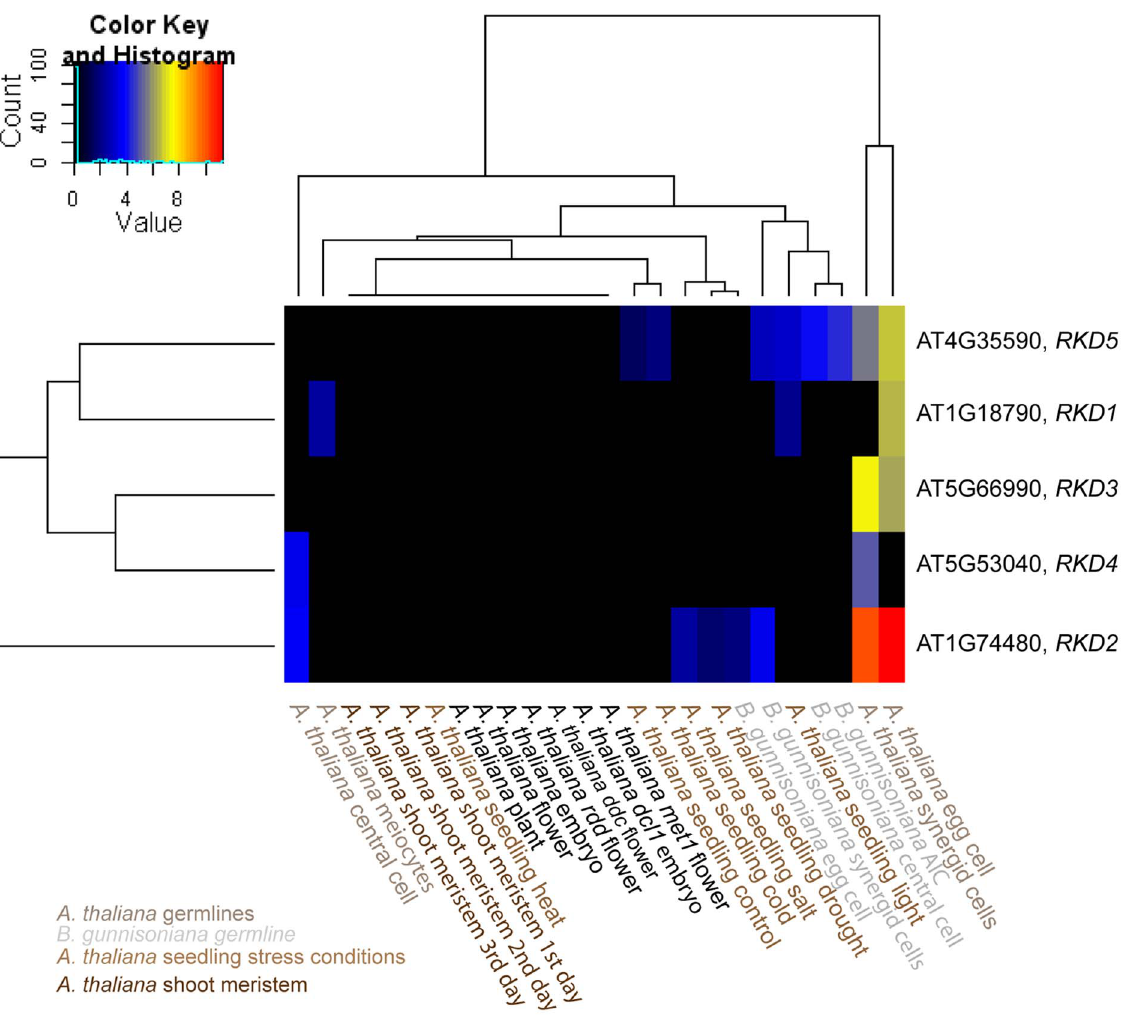
Figure 7. Heatmap clustering of members of the AtRKD gene family. Heatmap of normalized log2 transformed read counts from different Arabidopsis and Boechera cell- and tissue-types [13,62–66]. The hierarchical clustering of samples and genes was based on euclidean distance and hierarchical agglomerative clustering. No row scaling of colours was applied. Red denotes high expression and black low expression.